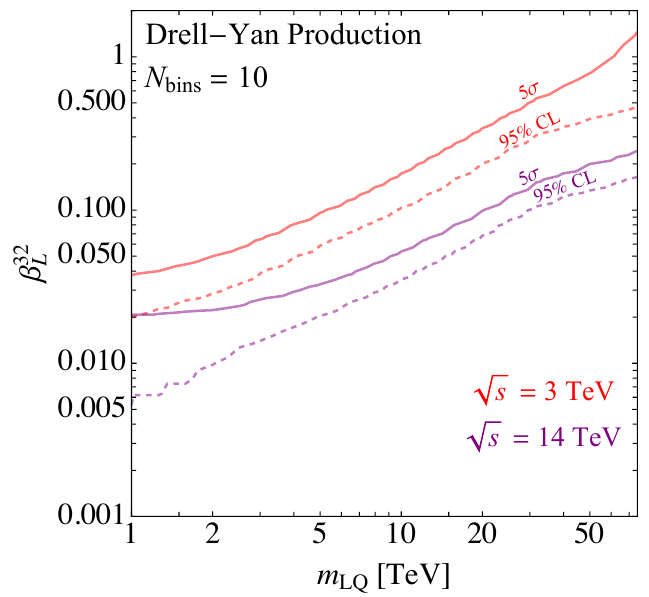
Figure 12 . The 95% CL exclusion bound (dashed) and the 5 σ discovery (solid) reach of the DY √ interference channel with s = 3 , 14 TeV. In calculating these bounds we neglected the systematic uncertainties. We also use 10 bins in η for the final be jets. The DY channel bounds only depend on the β 32 couplings, thus are the same across the four scenarios of table